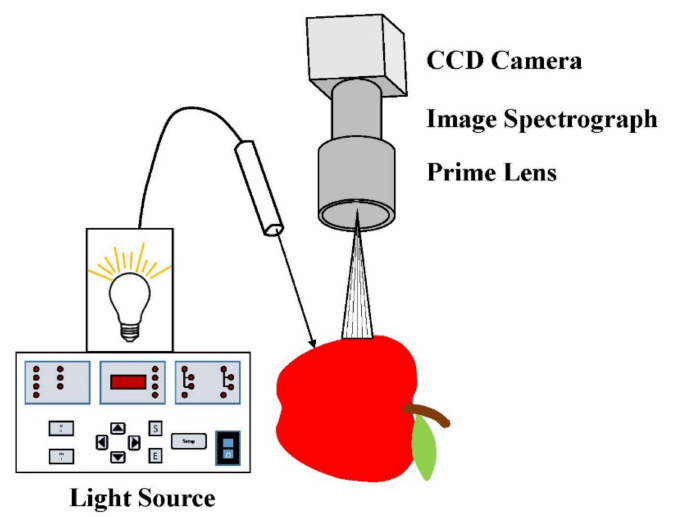
Figure 6. The configuration of hyperspectral line-scan